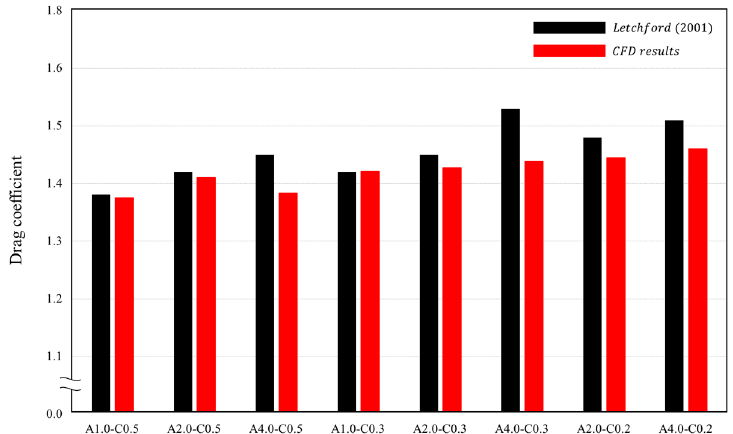
Figure 4. Suitability verification of CFD analysis.